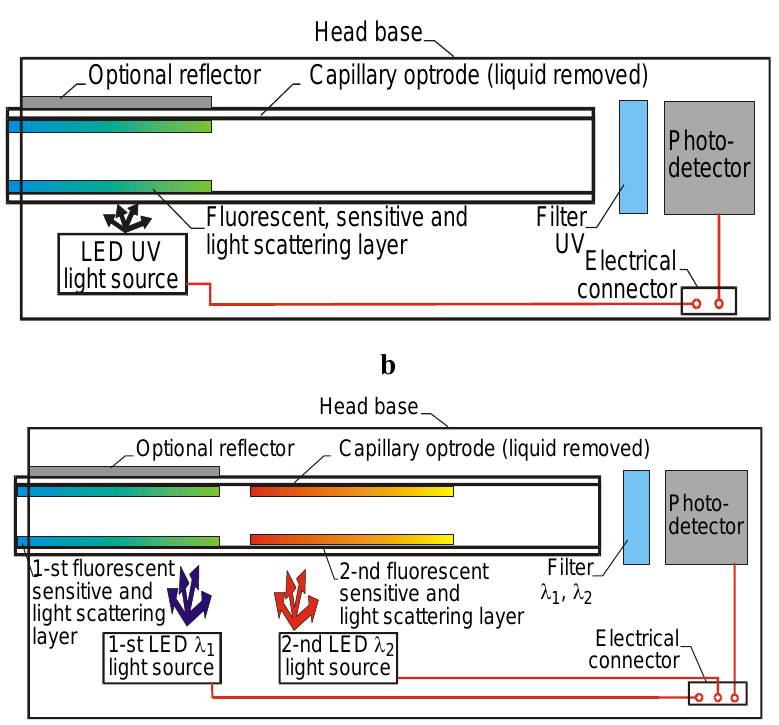
Figure 9. a) Head with capillary optrode using a fluorescent, sensitive and light-scattering layer [66]; b) Head with capillary optrode using 2 fluorescent, sensitive and light-scattering layers